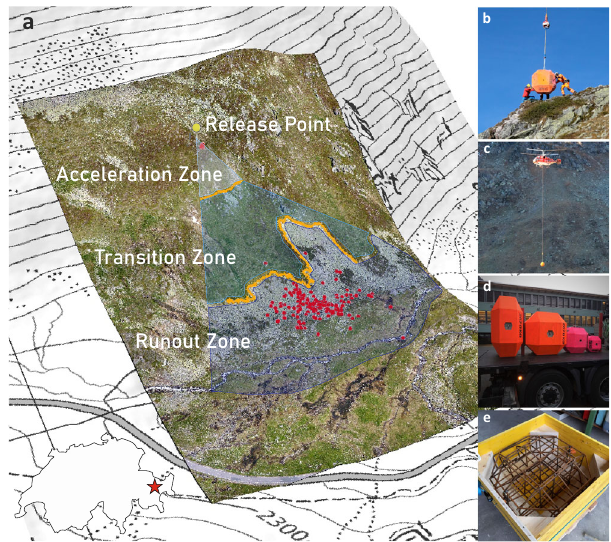
Fig. 1 Aerial test site overview and experimental impressions of helicopter-aided single-block rockfall experiments. a Perspective overview of the rockfall test site Chant Sura located on the Flüelapass, Switzerland, with its geographic location depicted in the lower-left corner. A UAS-derived orthophoto is draped over the corresponding digital elevation model on top of a regular swisstopo map (Source: Federal Of fi ce of Topography swisstopo). The release platform is marked with a yellow pin. The ensemble of deposited rocks is indicated with red markers. The acceleration zone above the cliff, transition zone between cliff and scree line, and runout zones/scree fi eld are labelled. b Reception of